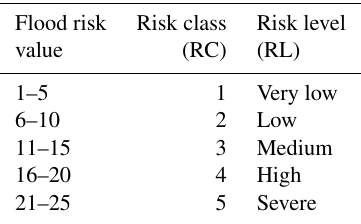
Figure 2. Nightlights over Canada shown as (a) continuous spec- trum and (b) classified as shown in Table 3 into very low luminos- ity (0–5), low luminosity (6–10), medium luminosity (11–30), high luminosity (31–59), and very high luminosity (60–63). Table 4. Classes of flood risk in Canada, which results from the product of hazard and